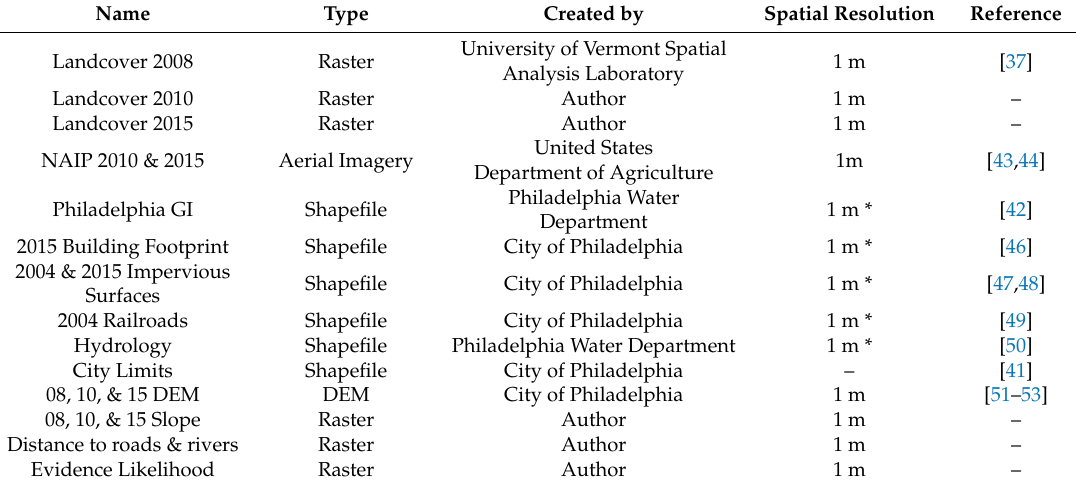
Table 2. Datasets used in the study to develop the future projection of Philadelphia in